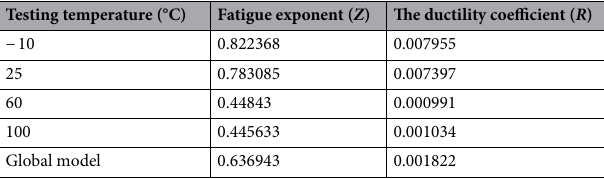
Table 4. The morrow equation constants versus the testing temperature.